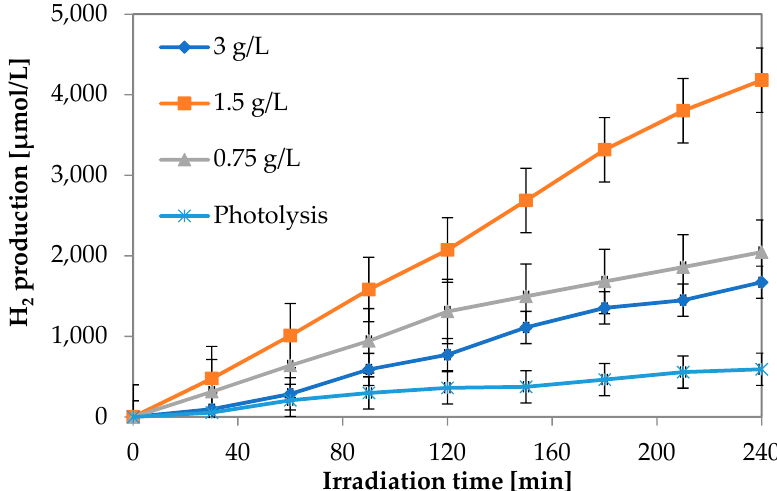
Figure 3. Hydrogen production during the irradiation time as a function of catalyst dosage. Glycerol initial concentration: 5 wt %; solution pH: 6; visible light intensity: 32 mW/cm 2 ; photocatalyst: 1.08Cu_ZnO.